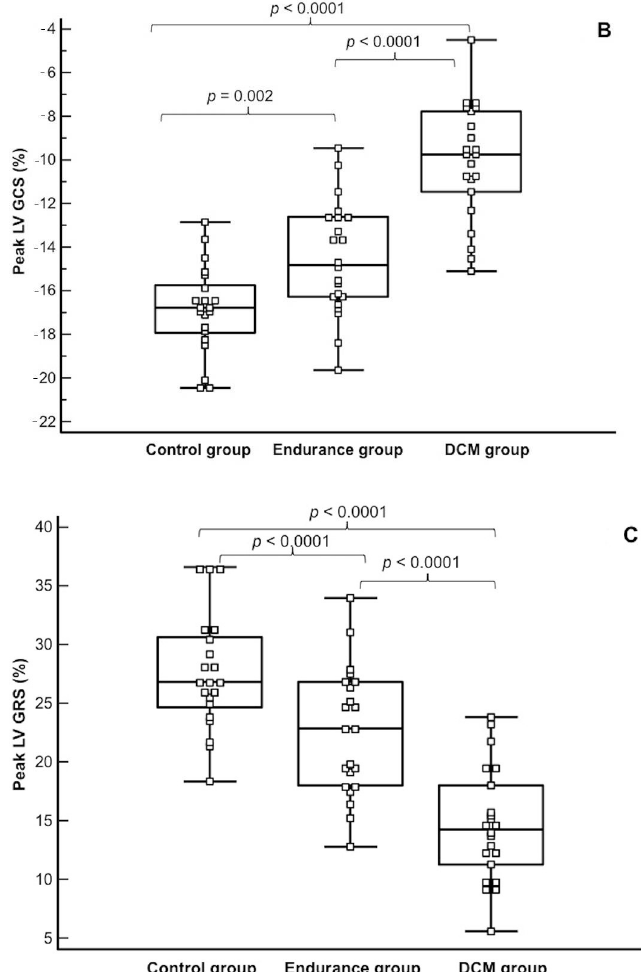
Figure 2. Comparison of the left ventricular peak global longitudinal ( A ), circumferential ( B ) and radial ( C ) strains between the studied groups. GCS—global circumferential strain, GLS—global longitudinal strain, GRS—global radial strain, LV—left ventricular.